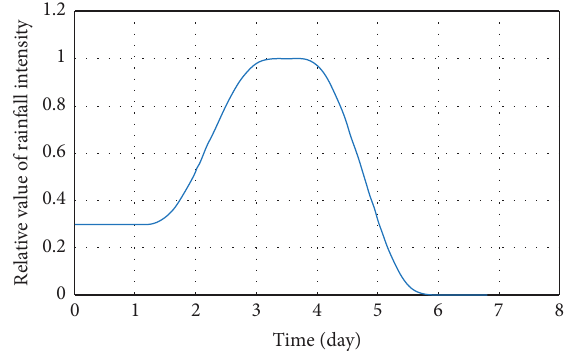
Figure 6: Curve of penetration velocity over